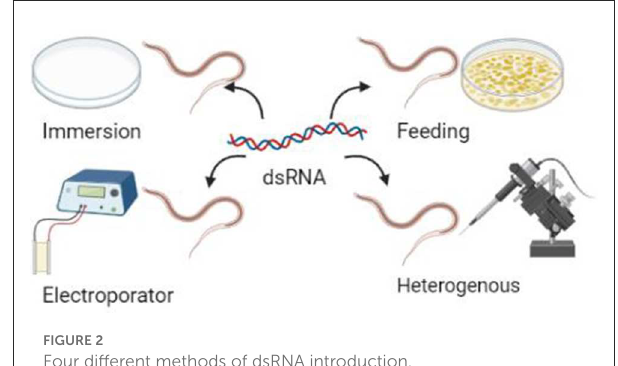
FIGURE2 Four different methods of dsRNA